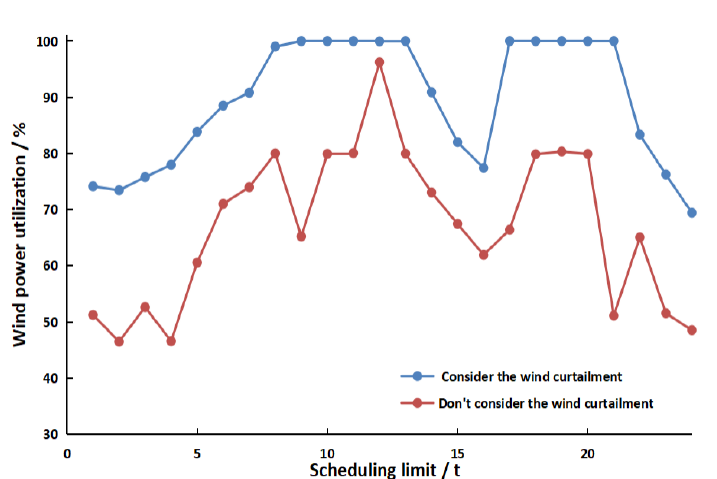
Figure 2. Wind power utilization rate